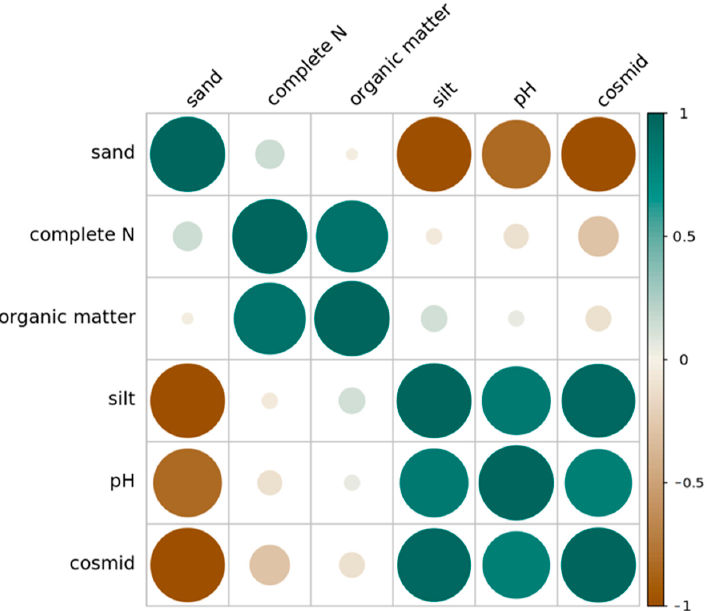
Figure 6. Pearson correlation between soil physical and chemical properties across all land use types and soil depths in the Taojia River basin. Note: brown—darker colors and larger circles indicate p -values closer to − 1 and a more significant correlation between the two indicators. Green—darker colors and larger circles indicate p -values closer to 1 and a more significant correlation between the two indicators.